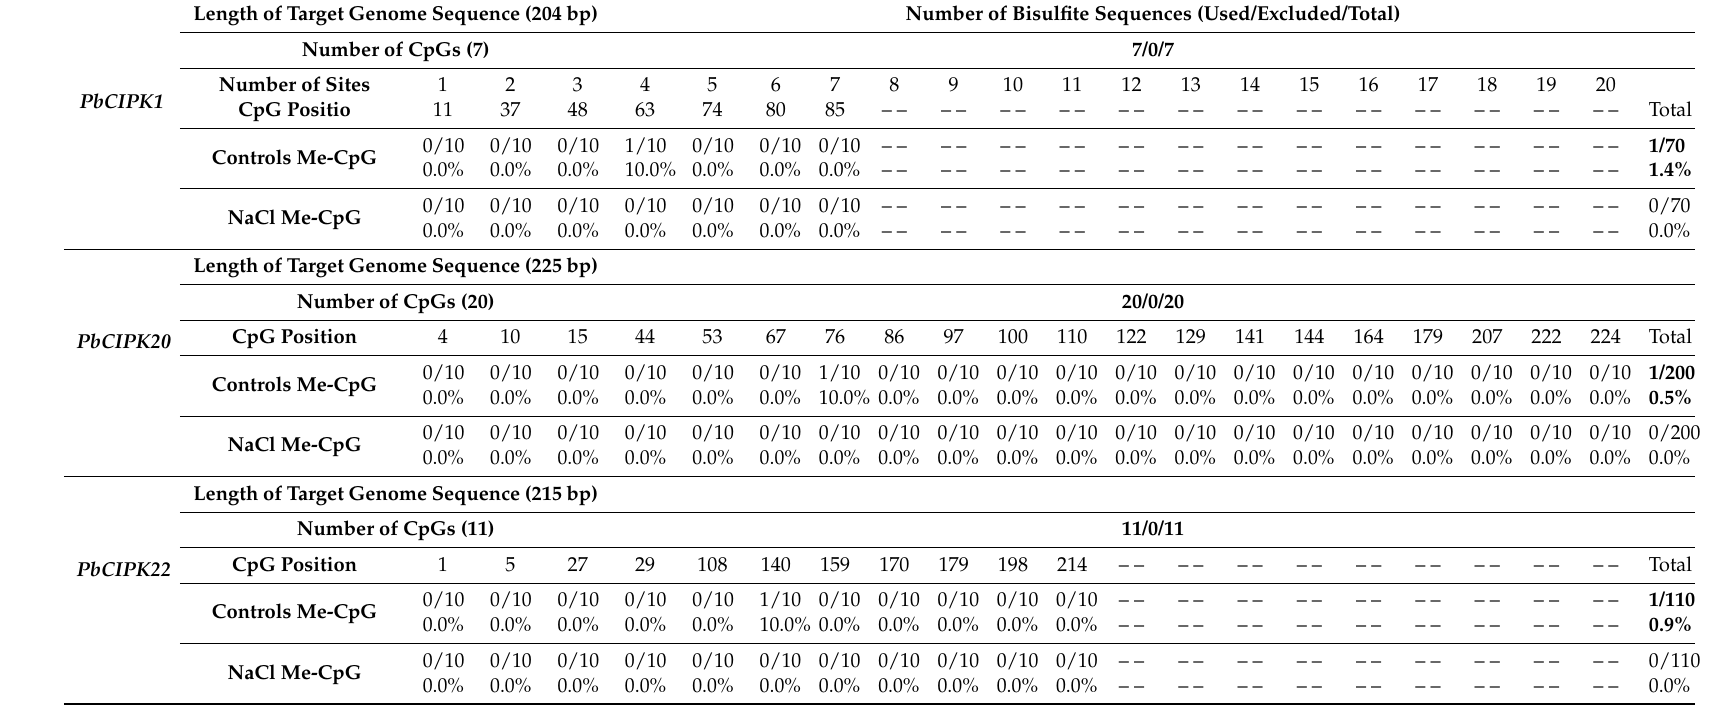
Note: 10 replicates per DNA sample were analyzed. The percentage of CpG methylation level is